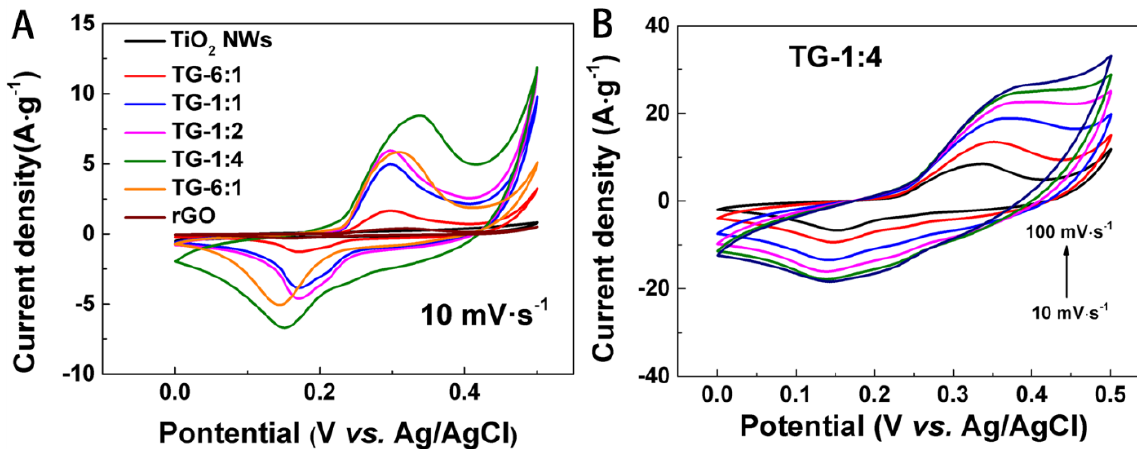
Figure 6: CV curves of the TiO 2 NWs, rGO, and TiO 2 NWs-rGO nanocomposite. A: rGO, TiO 2 NWs, and TiO 2 NWs-rGO nanocomposite with different initial mass ratios of TiO 2 and GO at a scan rate of 10 mV s-1, B: TG-1:4 at various scan rates (10, 20, 40, 60, 80, and 100 mV · s −1 )